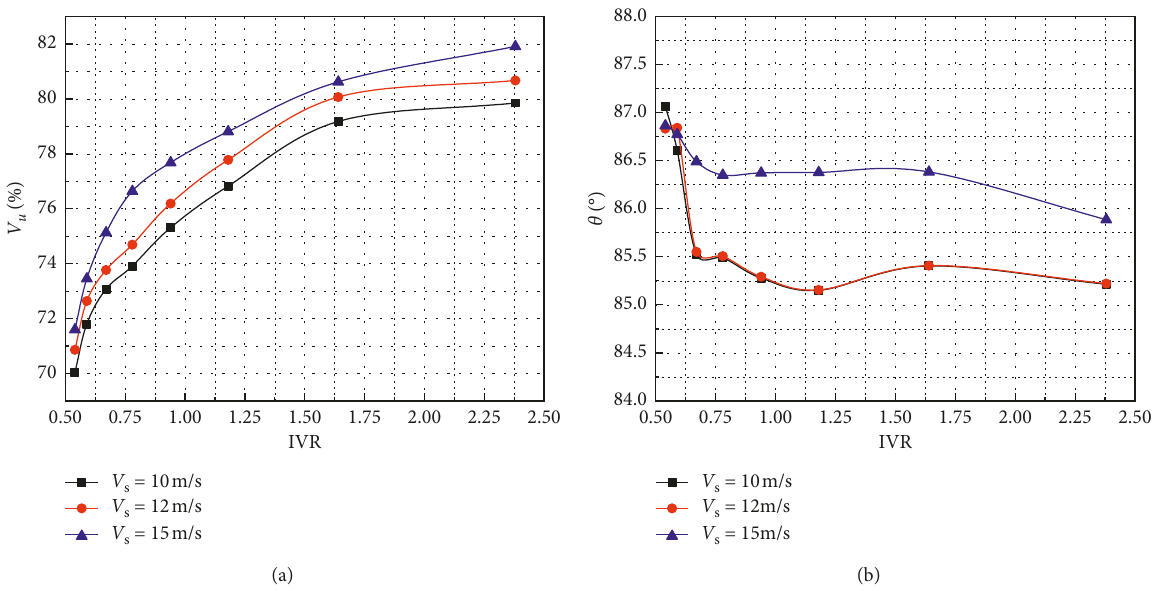
Figure 16: Hydraulic characteristics of inlet passage outlet with different ship speeds. (a) Axial velocity distribution coefficient V Weighted-velocity average swirl angle θ .